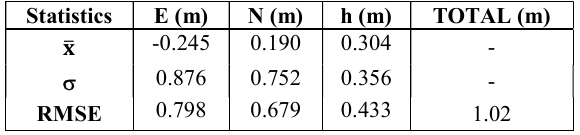
Table 1. Statistics: mean, standard deviation and RMSE of the checkpoints